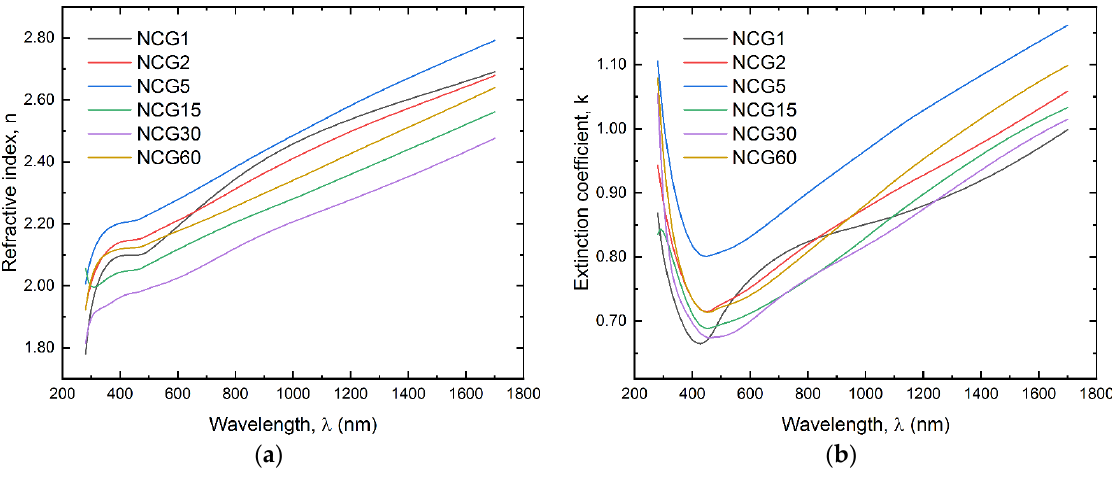
Figure 4. The ( a ) refractive index and ( b ) extinction coefficient of the NCG samples. Table 1. Recent studies of graphene and graphene-derived materials’ optical constants, refractive index (n) and extinction coefficient (k), obtained by spectroscopic ellipsometry analysis.